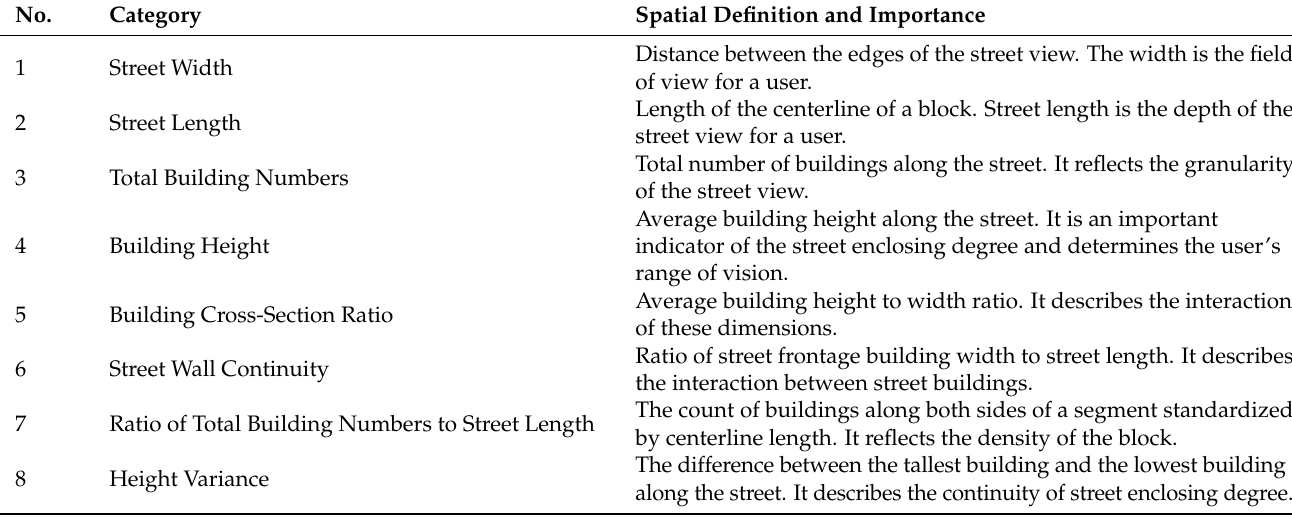
Table 1. Spatial definition and importance of